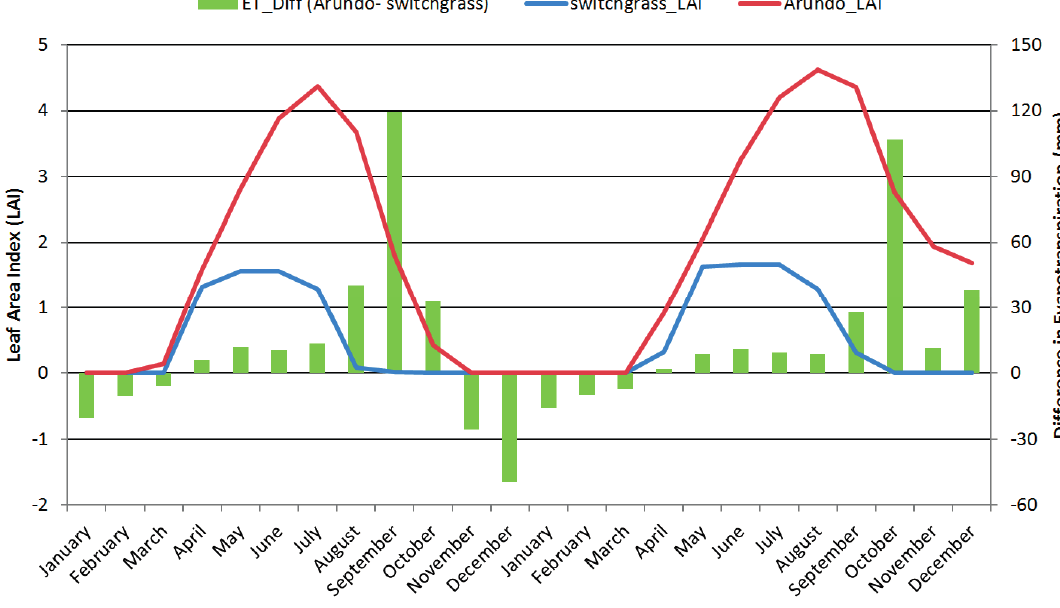
Figure 4. Differences in monthly Leaf Area Index (LAI) and Evapotranspiration (ET) between Arundo and switchgrass over two consecutive years